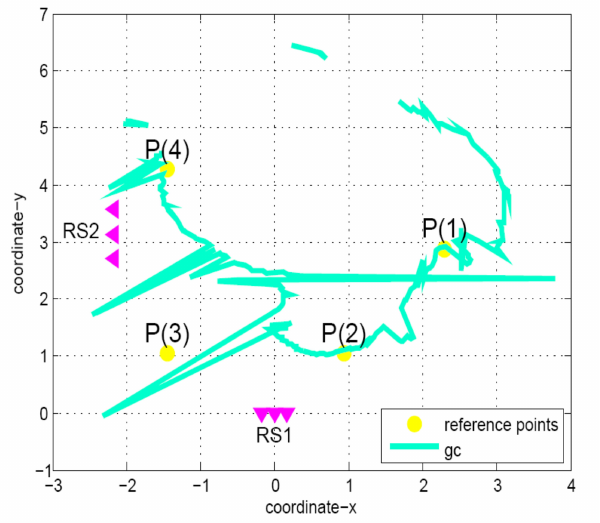
Figure 13. The trajectory of movement of the observed person after application of the straight-line method localization.